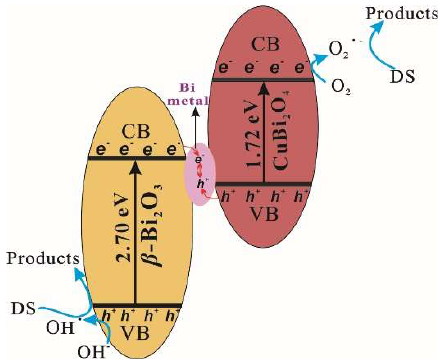
Figure 10. Supposed photocatalytic mechanism of CuBi 2 O 4 / β -Bi 2 O 3 by the Z-scheme theory.